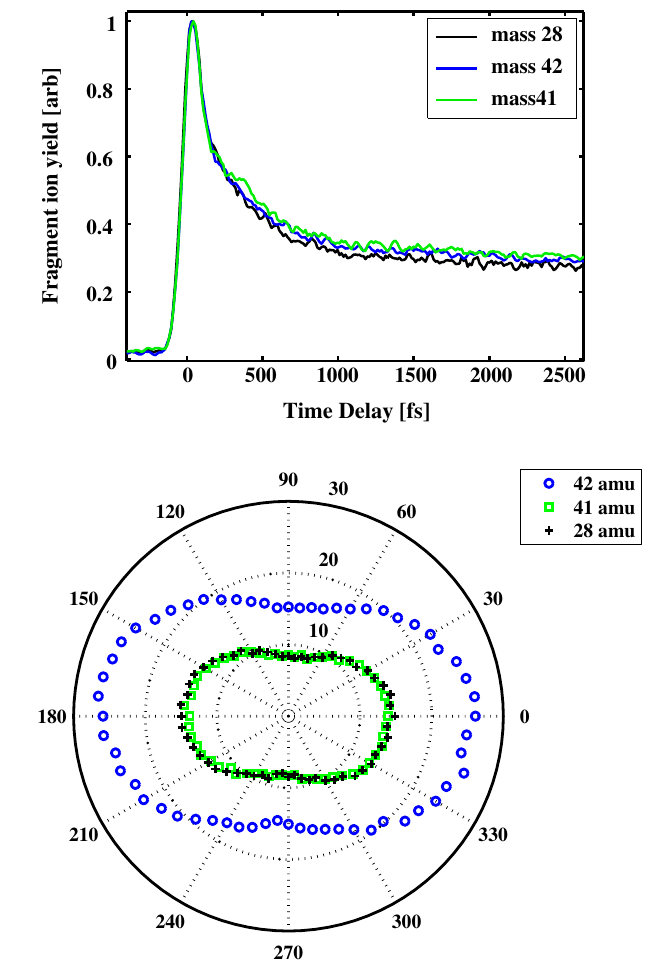
FIG. 3. Top panel: Pump-probe signals from 42, 41, and 28 amu fragments. The signal for each fragment is normalized. Bottom panel: Pump-probe ion yield vs pump polarization at 200 fs pump-probe delay. The azimuth angle corresponds to the relative polarization between the pump and the probe beams, while the radial distance is the ion count in arbitrary